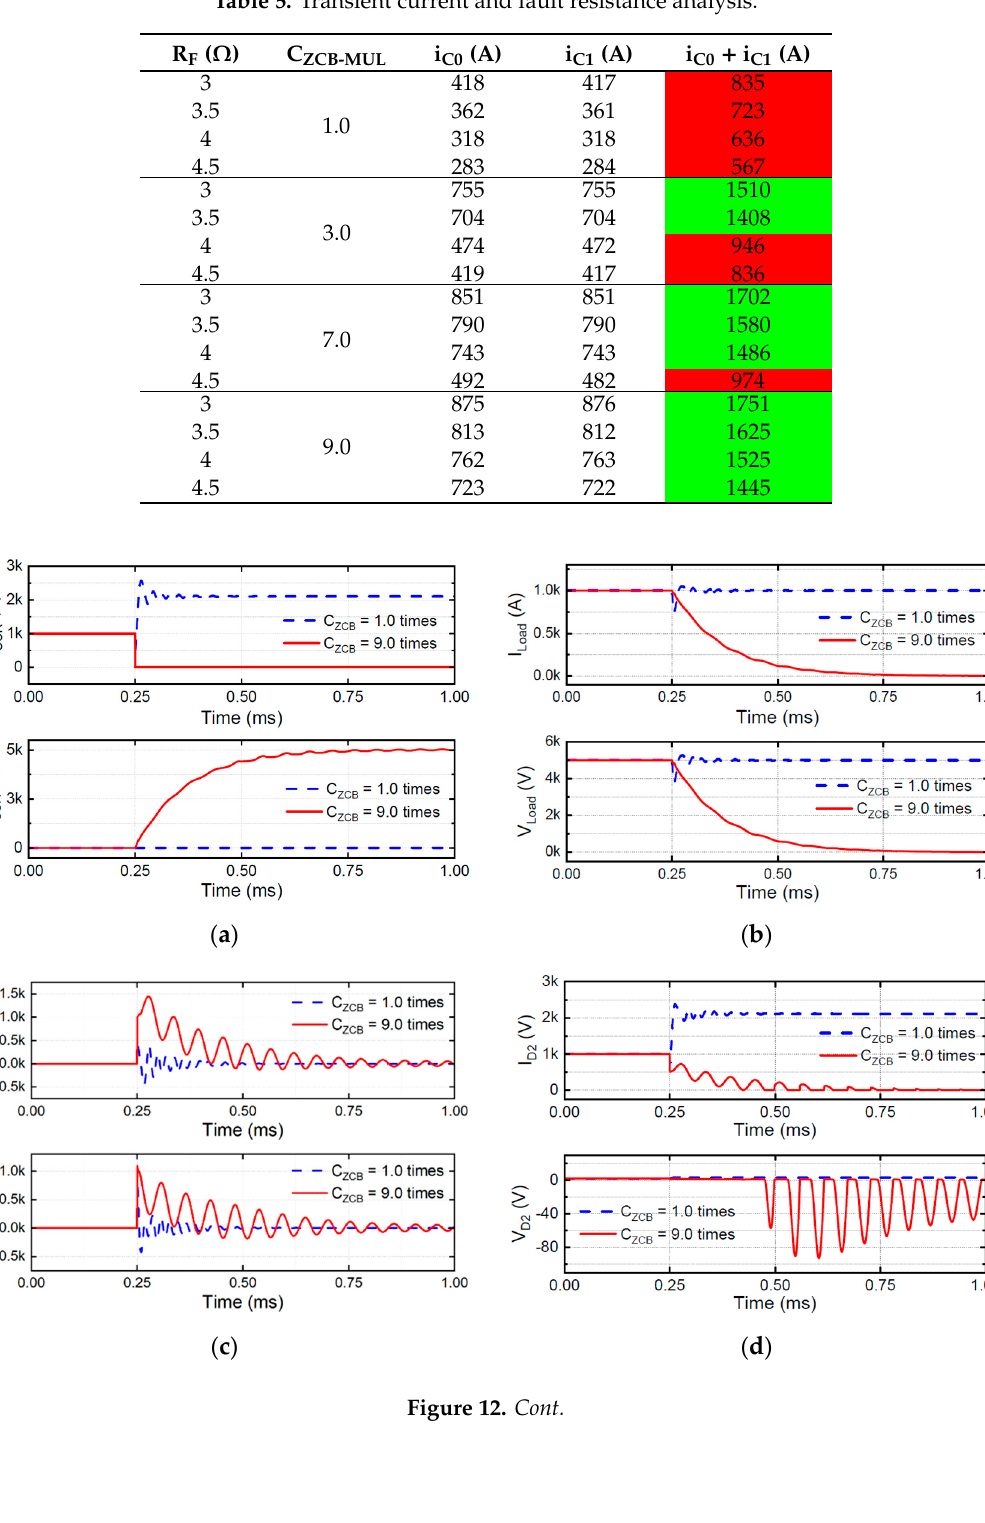
Table 5. Transient current and fault resistance